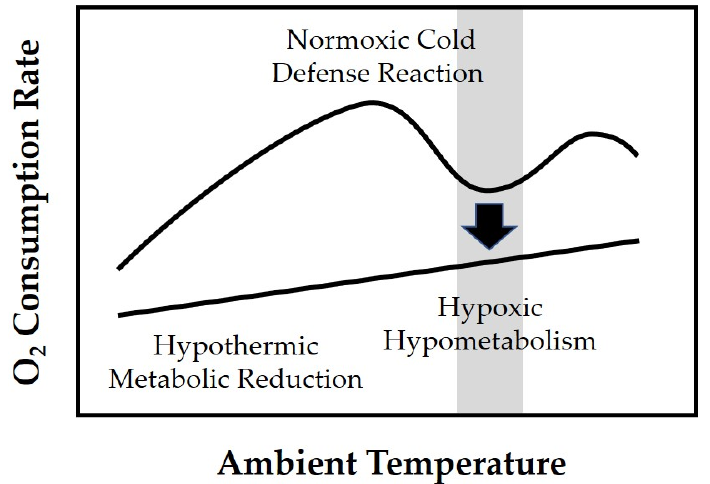
Figure 3. Self-protective role of hypothermia in hypoxic neonates. As hypoxia and acidosis exert a suppressive effect on non-shivering thermogenesis in the brown adipose tissue, the usual ther- moregulatory increase in O 2 consumption rate with decreasing ambient temperature is replaced by a direct cold-induced metabolic reduction, similar to induced hypothermia. Moreover, a spontaneous decrease in O 2 consumption rate (arrow) in response to hypoxia may already occur at thermoneutral temperatures (shaded area), suggesting that neonates have a “hibernation-like” ability to reduce their metabolic rate (hypoxic hypometabolism) before any drop in body temperature (adapted from rat study data by Mortola [46]).